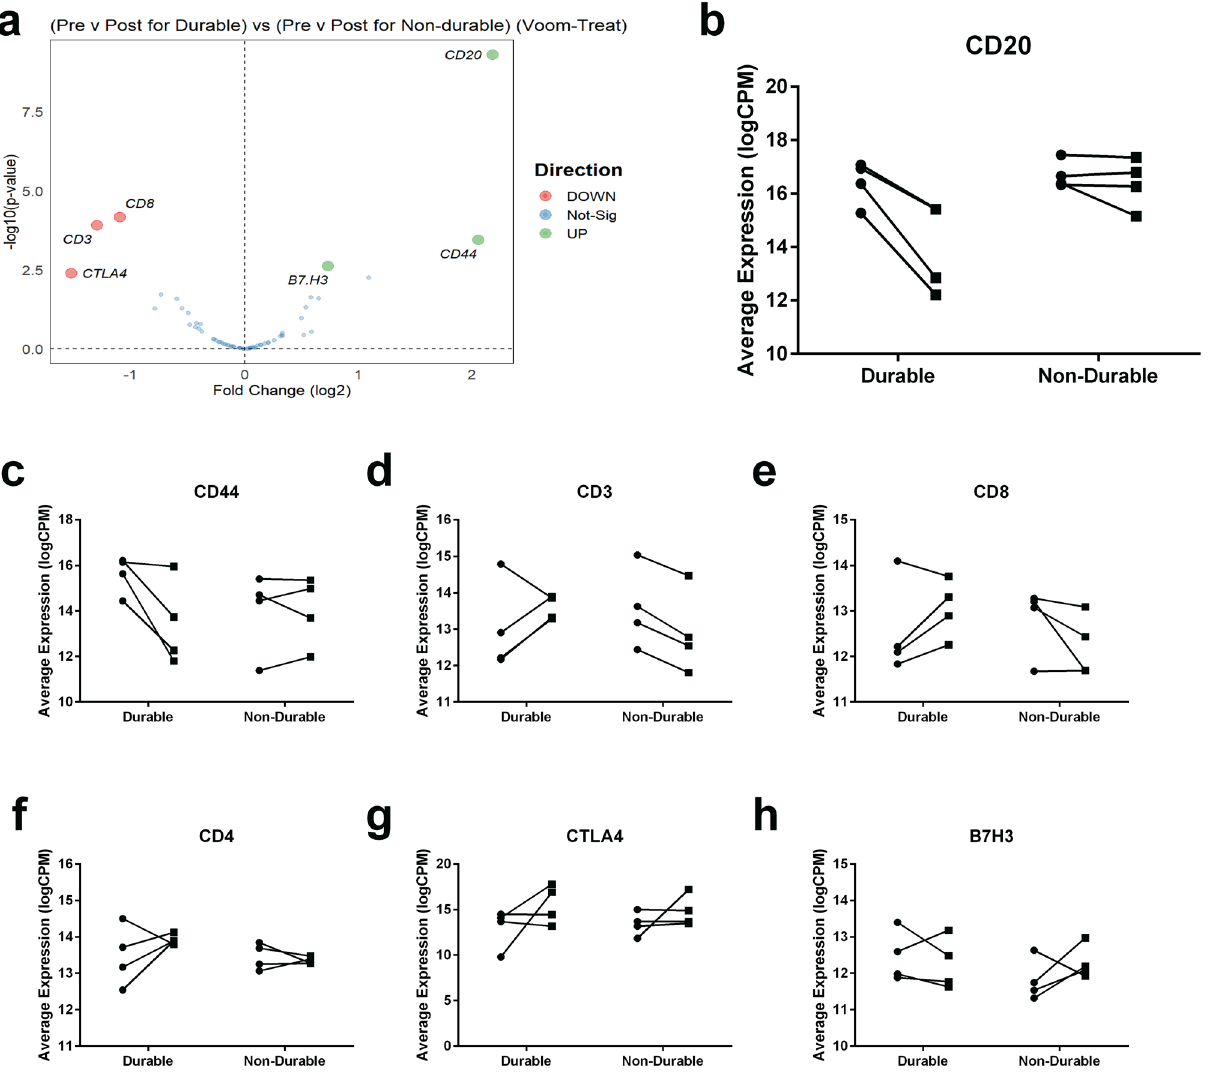
Figure 5. Changes in tumour burden and CD8 expression are associated with durable response to CDA. ( a ) Results of voom-limma-treat multiple comparisons of (pre vs. post for durable) versus (pre vs. post for non- durable). ( b )–( h ) Average marker expression pre- versus post-CDA in durable and non-durable responders. ( b ) CD20, ( c ) CD44, ( d ) CD3, ( e ) CD8, ( f ) CD4, ( g ) CTLA4, ( h )